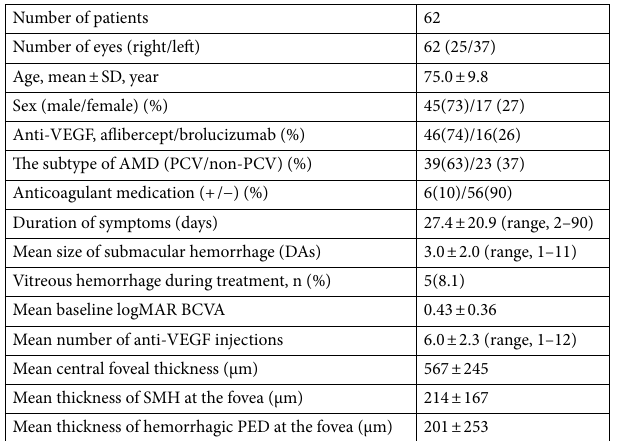
Table 1. Clinical characteristics of the patients with SMH secondary to neovascular AMD. SMH submacular hemorrhage, AMD age-related macular degeneration, SD standard deviation, VEGF vascular endothelial growth factor, PCV polypoidal choroidal vasculopathy, DAs disc areas, BCVA best-corrected visual acuity, PED pigment epithelial detachment.